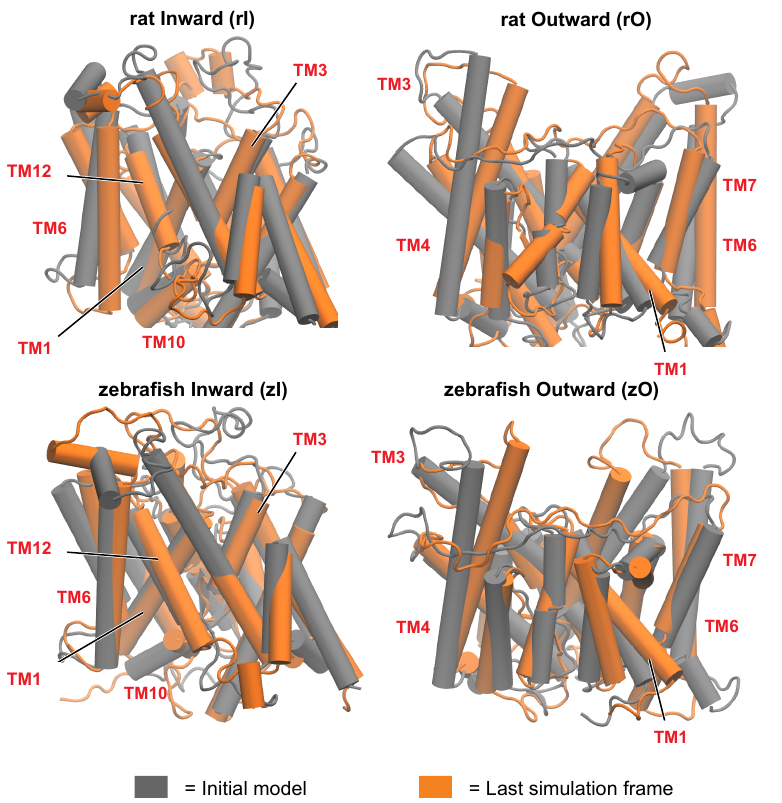
Figure 3. First (grey) and last (orange) frame of the simulation, for rat and zebrafish prestins in the inward-open and outward-open conformations. The rearrangement of the helices is more pronounced in the outward open conformations. Some of the most functionally relevant transmembrane helices (TM), as highlighted in this study, are